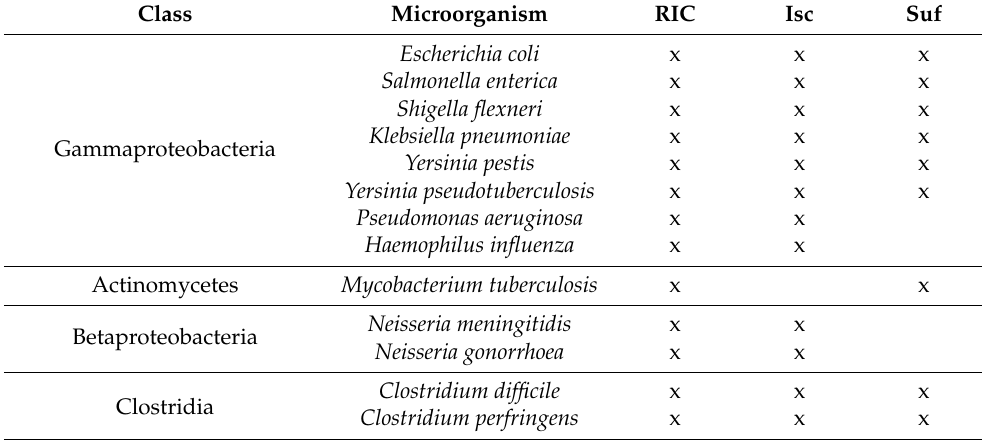
Table 5. Distribution of RICs in